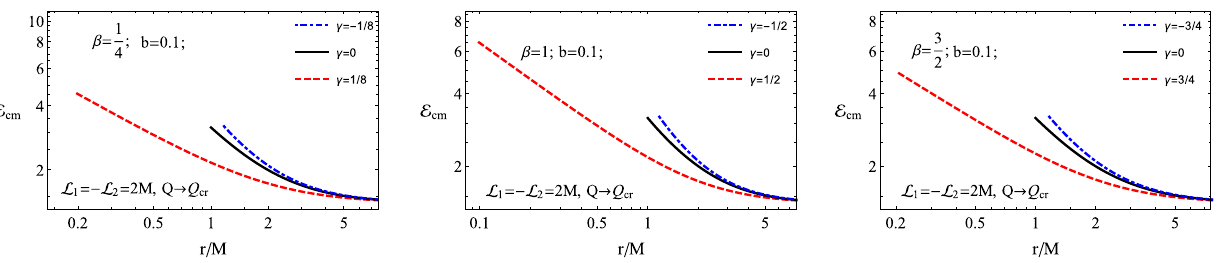
Fig. 16 Dependence of center of mass energy of magnetized and neutral particles for the different values of the EMS parameters γ and